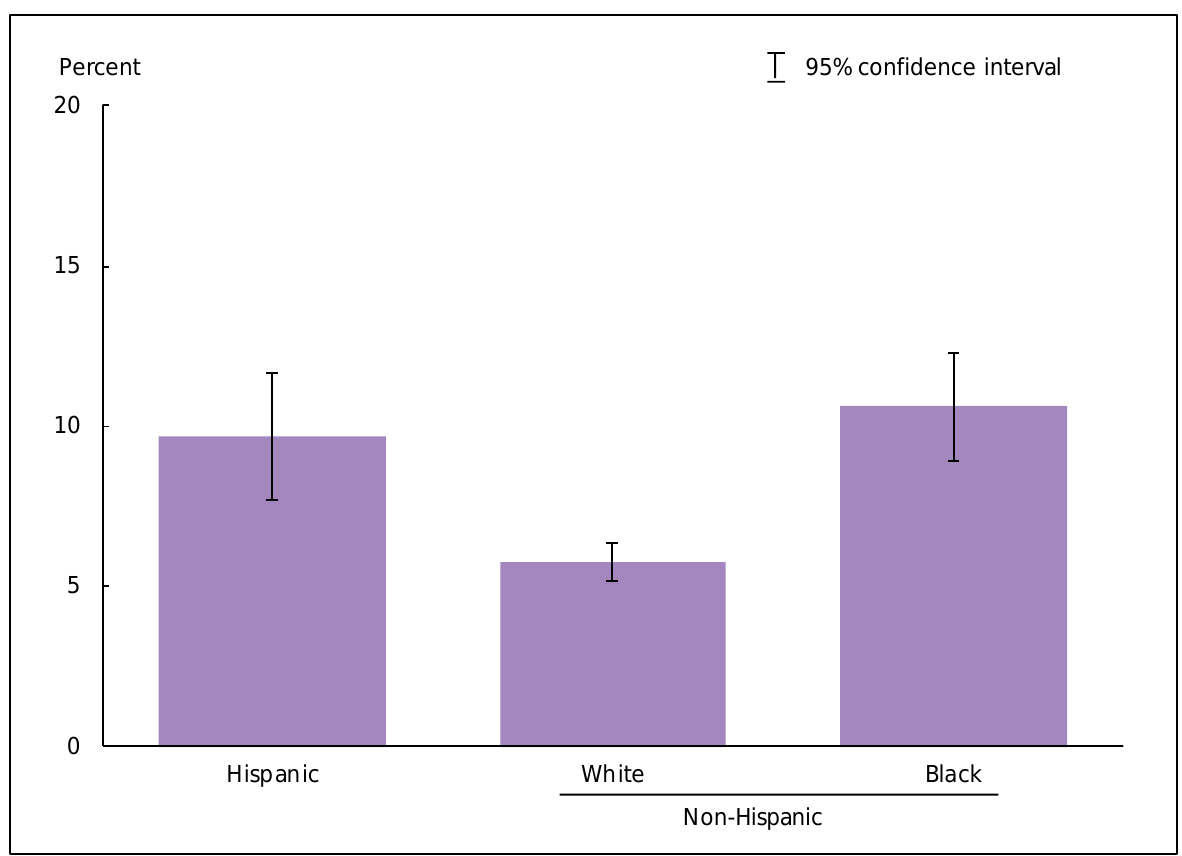
Figure 12.3. Age-sex-adjusted percentage of adults aged 65 and over who needed help with personal care from other persons, by race and ethnicity: United States,